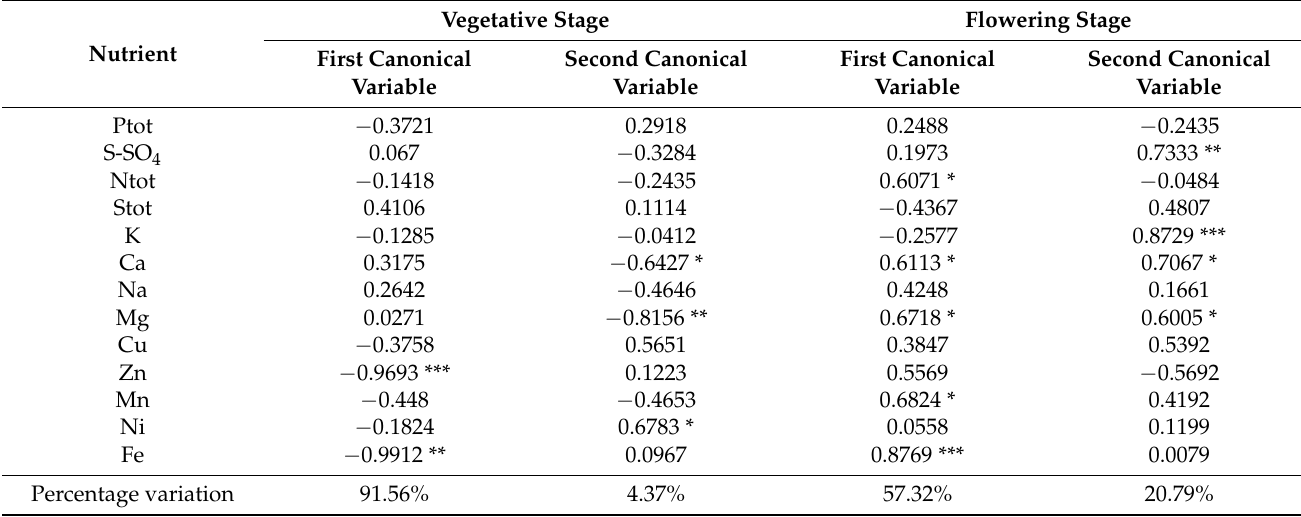
Table 5. Correlation coefficients between the first two canonical variables and nutrients in both terms (N = 90).